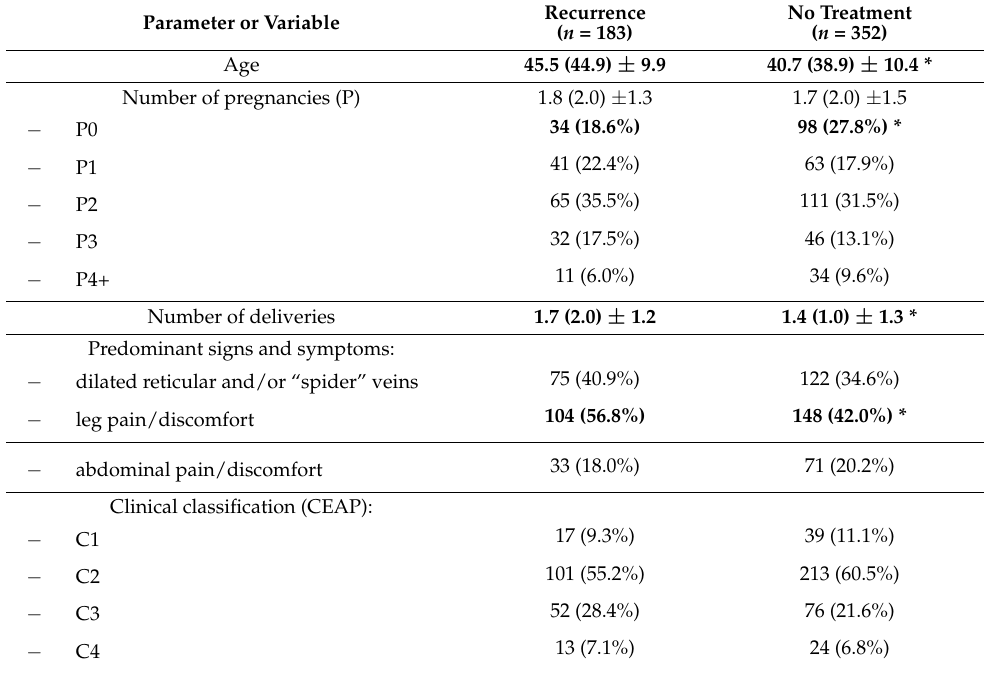
Table 1. Characteristics of study groups. The values shown in table represent mean (median) ± SD,